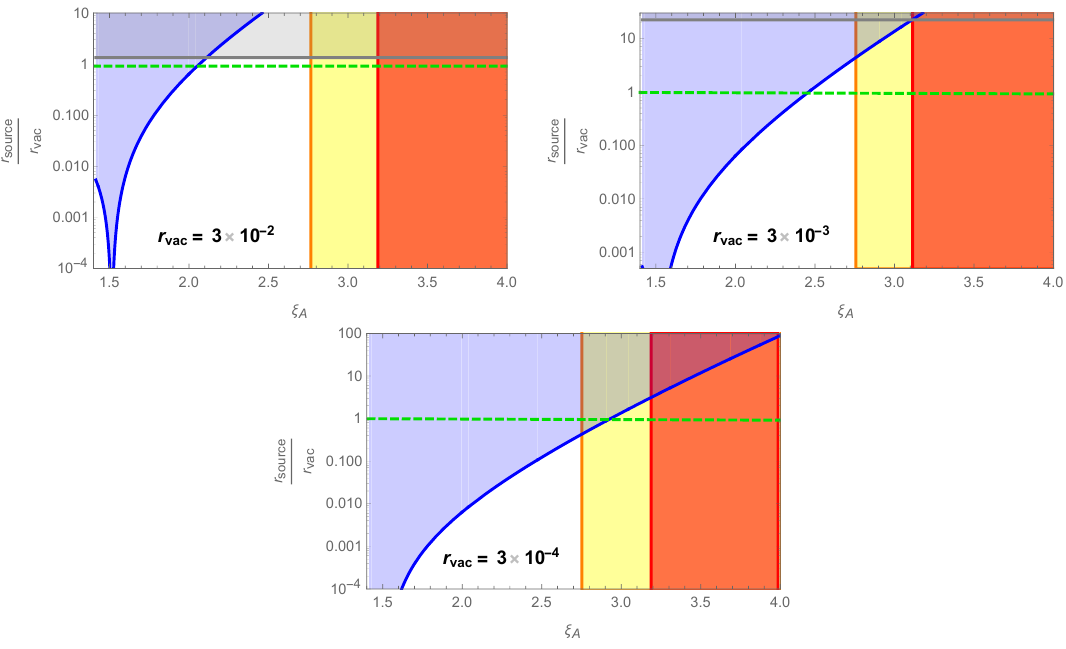
Figure 14 . Constraints on the fractional contribution of the sourced gravitational waves relative to the vacuum one, r source =r vac = ( r (cid:0) r vac ) =r vac , as a function of (cid:24) A for three di(cid:11)erent values of r vac = 3 (cid:2) 10 (cid:0) 2 (top left), 3 (cid:2) 10 (cid:0) 3 (top right), and 3 (cid:2) 10 (cid:0) 4 (bottom). The blue shaded area is excluded by the inconsistency of the slow-roll condition ( (cid:15) A =(cid:15) > 0 : 9), the yellow and orange areas by the large backreaction B A > 10 (cid:0) 2 and 10 (cid:0) 1 , respectively, and the gray area by the tensor-to-scalar ratio r > 0 : 07. The dashed green line marks r source =r vac =